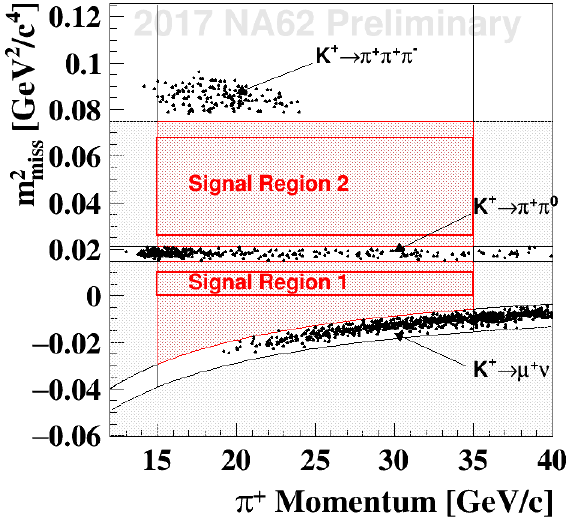
Figure 3. m 2 as a function of p π + ) after K + → π + ν ¯ ν selection. miss The two signal regions and their surrounding regions (control regions) are still